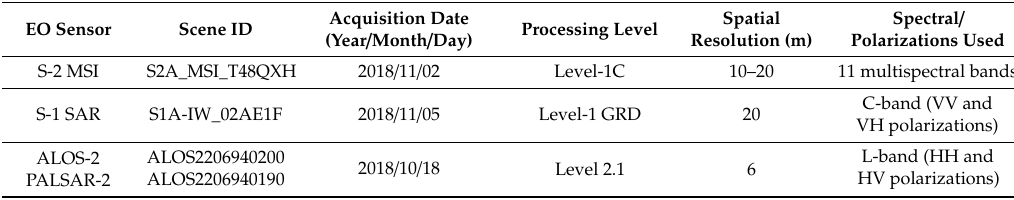
Table 1. The EO remotely sensed data used in this